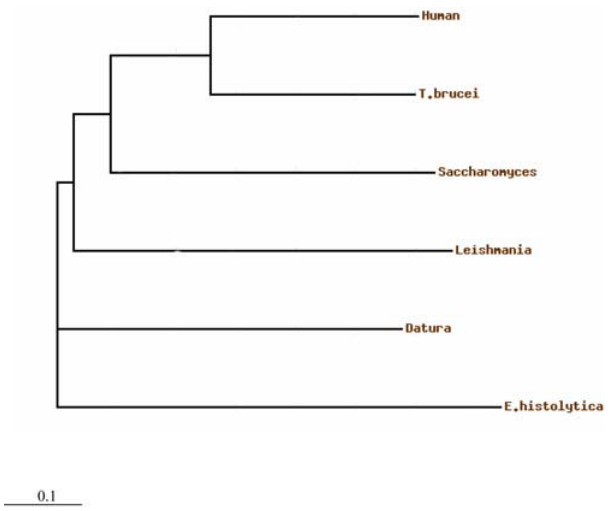
Figure 2. Phylogenetic tree using the amino acid sequences of putative ODC from E. histolytica and ODCs from other organisms. The TreeView program in the ClustalW displayed the phyletic trees derived from the multiple alignments.